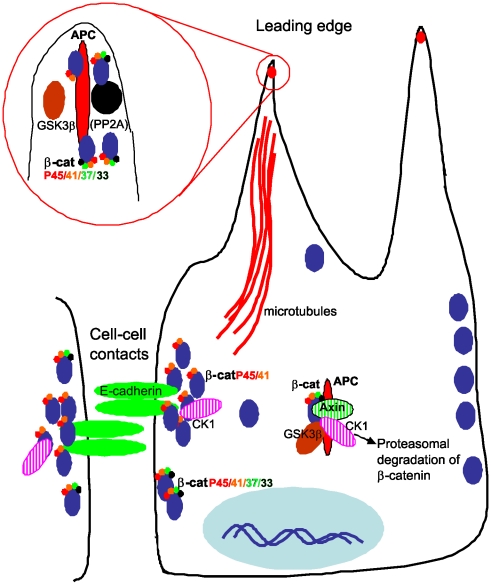
Functionally distinct populations of N-terminally phosphorylated β-catenin.P41/45-β-catenin associates with E-cadherin at cell-cell contacts. P33/37/41-β-catenin is also found at Ca2+-dependent cell contacts but is not detected in the complex with E-cadherin. P41/45- and P33/37/41-β-catenin associate with APC at the ends of microtubules at the leading edge of migrating cells. At the protrusions the phospho-β-catenin is rapidly phosphorylated and dephosphorylated. This complex is separate from the axin destruction complex that targets phospho-β-catenin for proteasomal degradation.